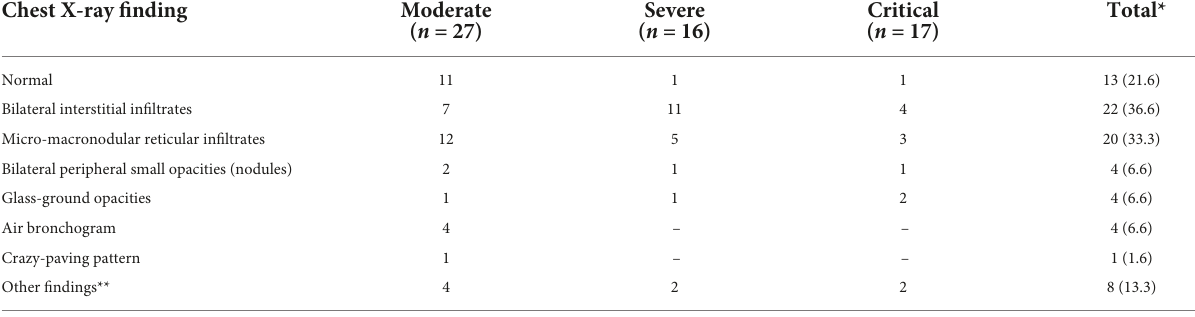
TABLE 4 Radiologic findings in 60 hospitalized patients according to clinical severity of COVID-19.